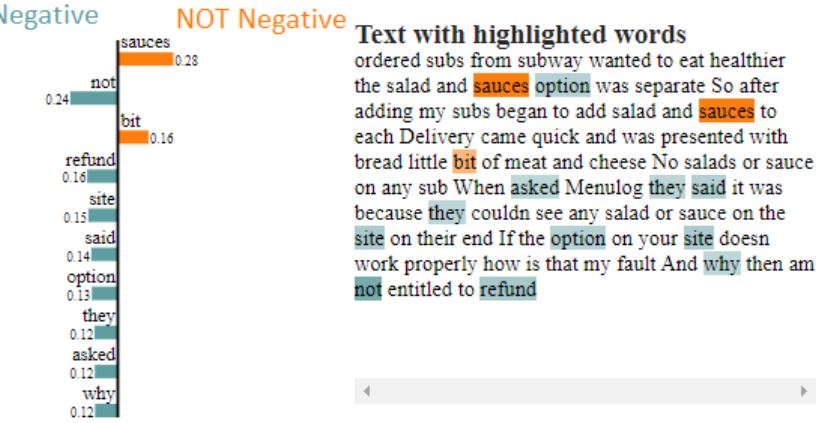
Figure 9. LIME explanation of the negative customer review detected by the LSTM model.